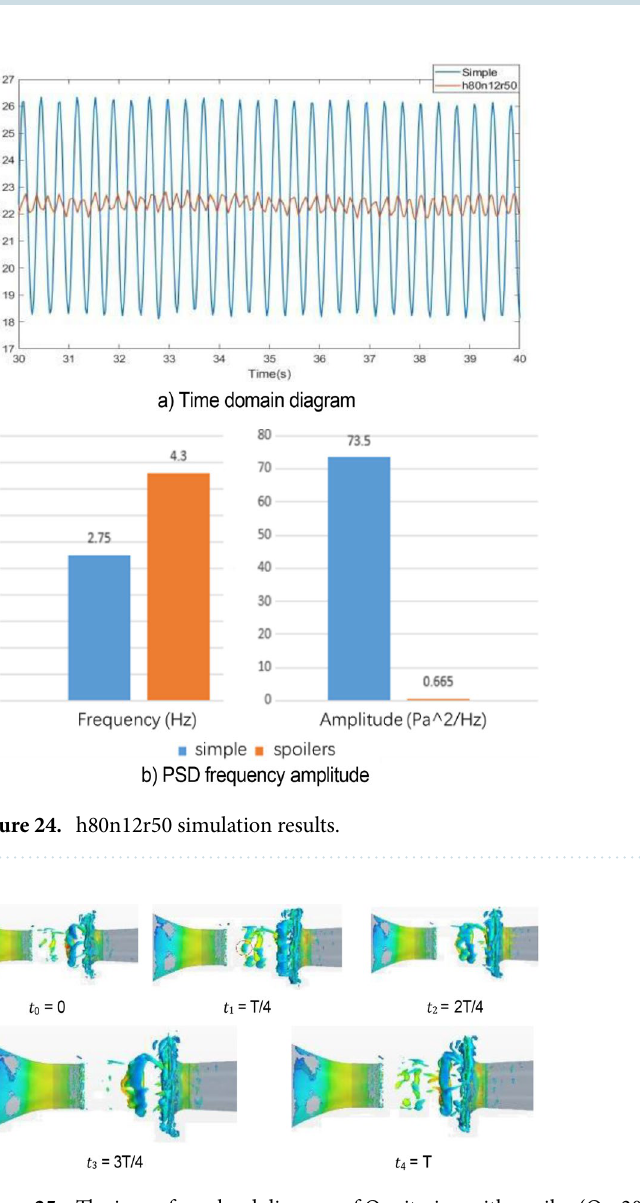
Figure 25. The isosurface cloud diagram of Q criterion with spoiler (Q = 200 /s 2